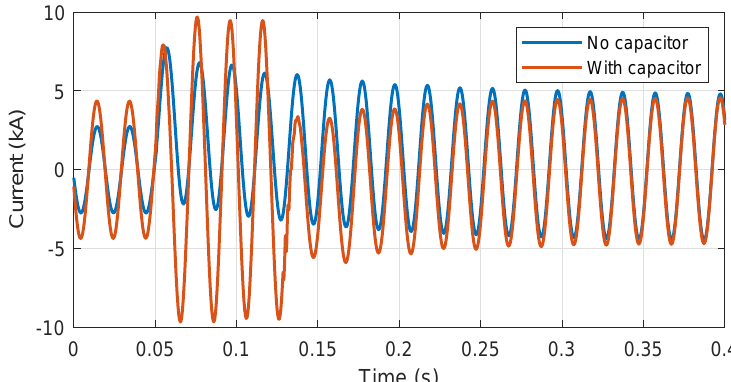
Figure 3. Fault current for same fault without and with series capacitor.